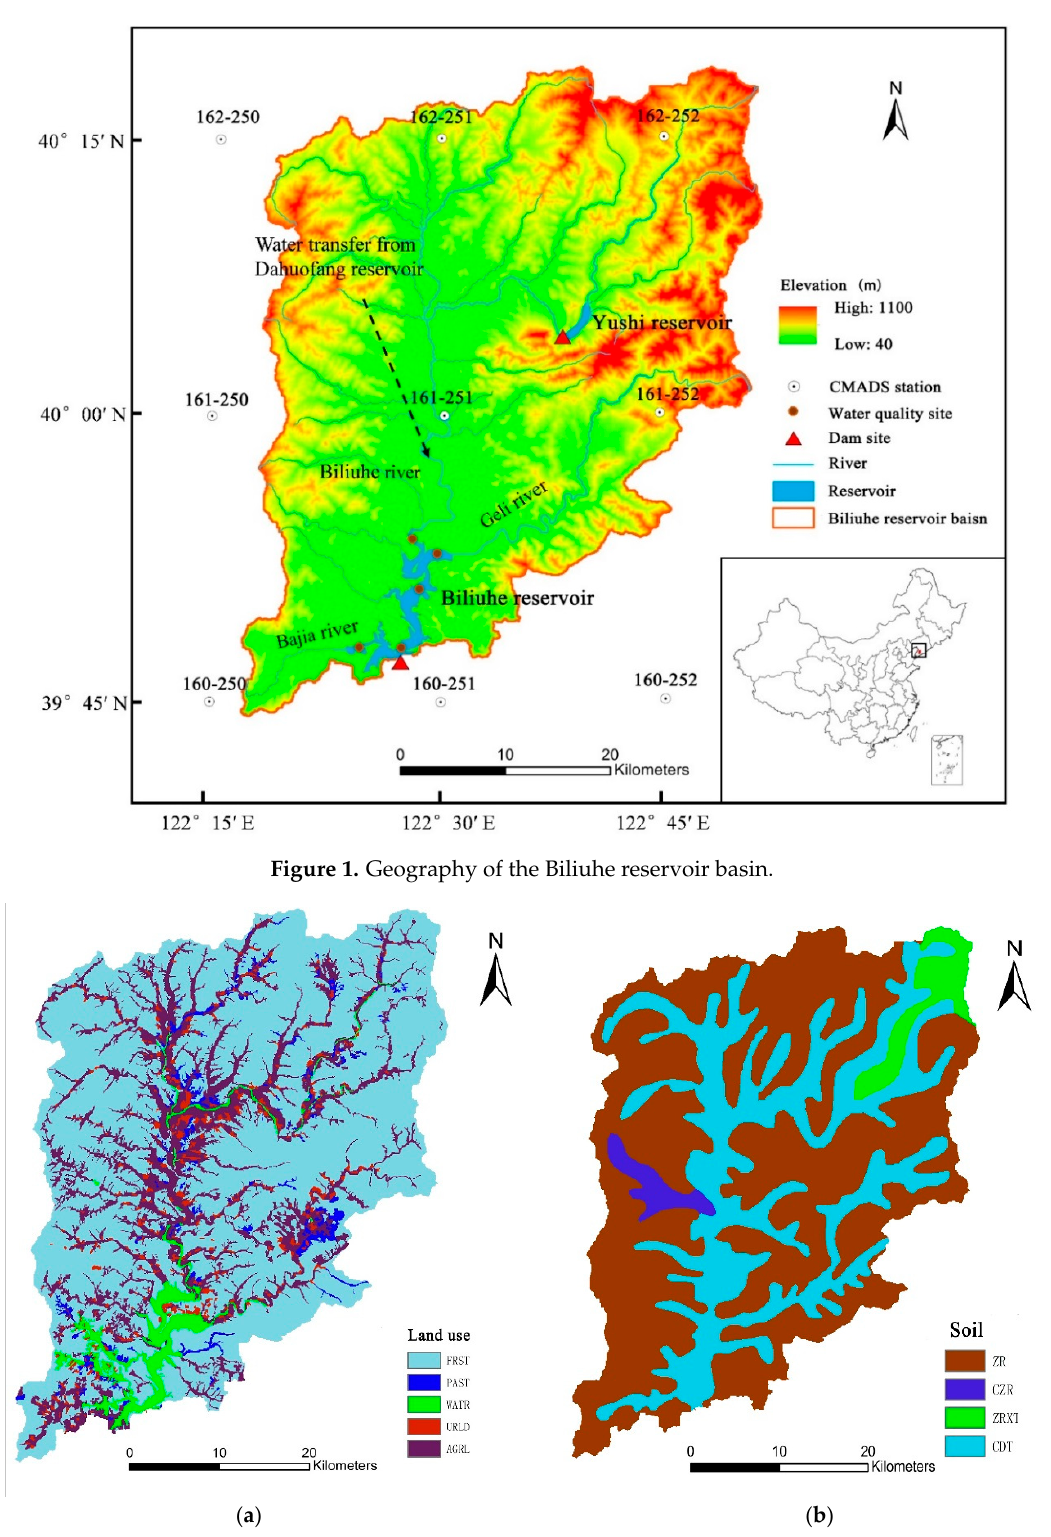
Figure 2. Land use types ( a ) and soil types ( b ) of the Biliuhe reservoir basin. Land use classes correspond to FRST (frost), PAST (pasture), WATR (water), URLD (low-density residential), and AGRL (agricultural land). Soil classes correspond to ZR (brown earth), CZR (young brown earth), ZRXT (meadow brown earth), and CDT (meadow soil).